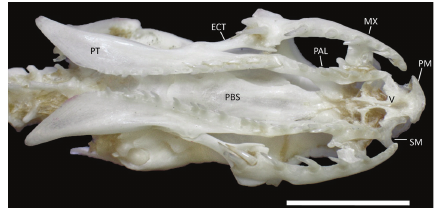
Figure 4: Ventral view of the skull of Sordellina punctata (IBSP 22313). Bar = 5mm. Abbreviations other than in previous figures are ect: ectopterygoid; pal: palatine; pbs: parabasisphenoid; pt: pterygoid; v: